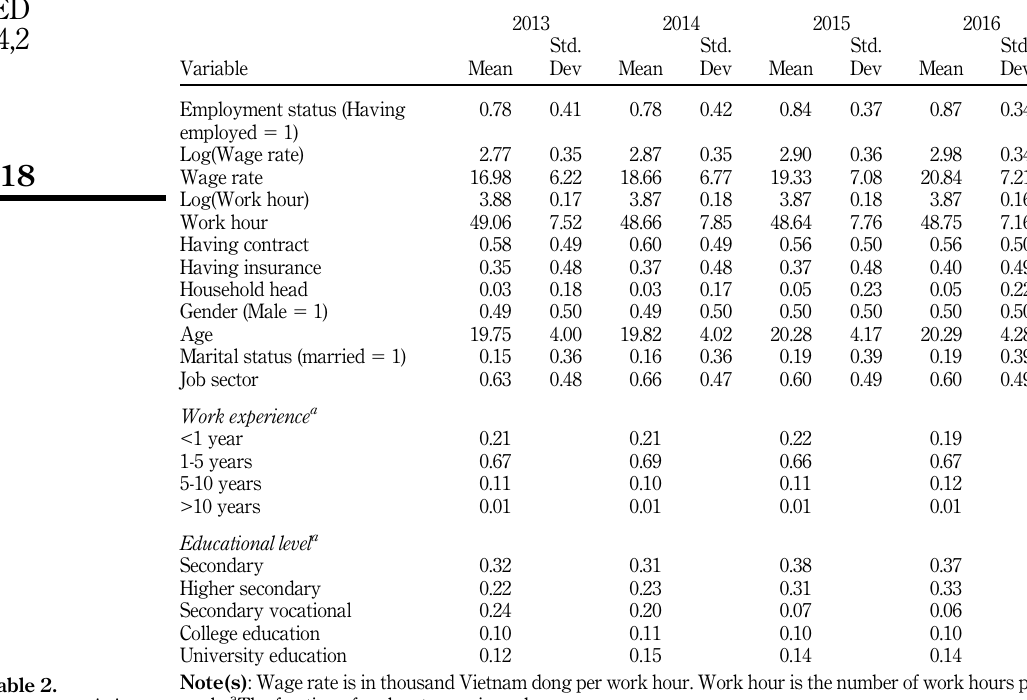
Table 2. Summary